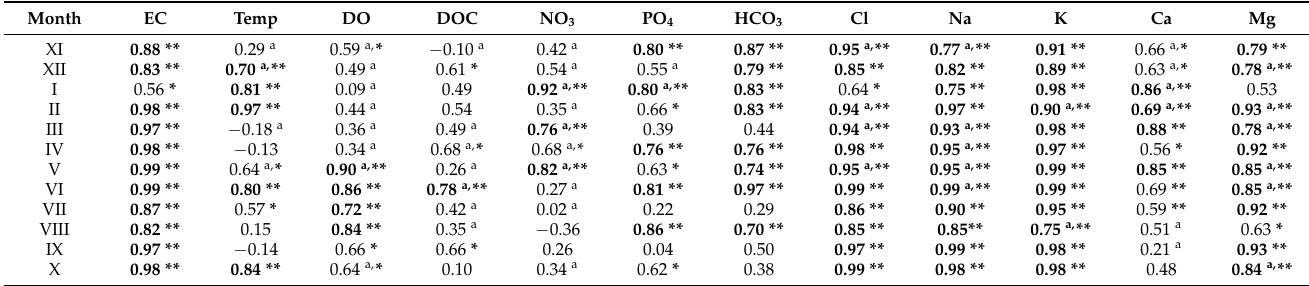
Table 3. Inter-annual Pearson and Spearman correlation coefficients for the individual